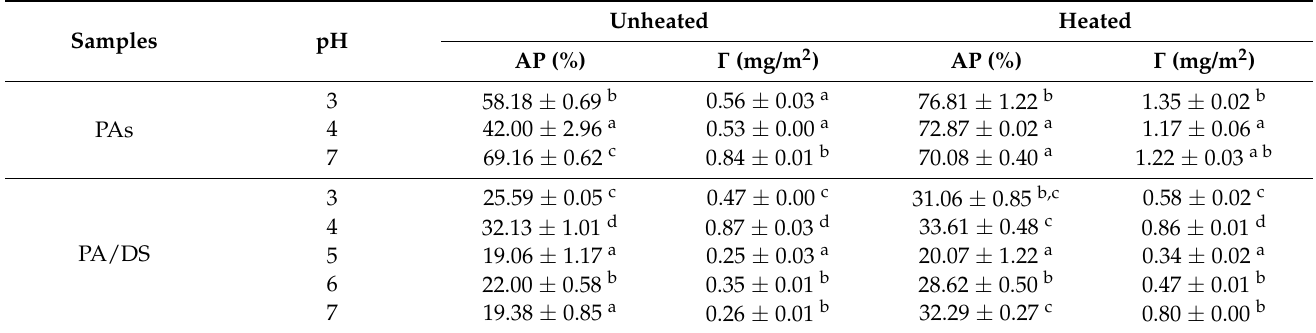
Table 4. Protein adsorption rate (AP) and interfacial protein content ( Γ ) of emulsions stabilized by PAs alone and PA/DS soluble